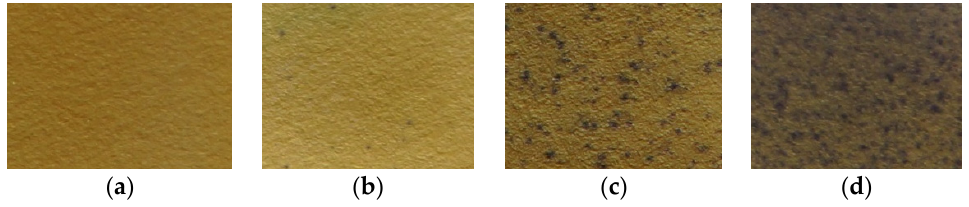
Figure 4. Reactive Papers visual inspection test examples. Change of colour to blue from yellow occurs on exposure. Amount of colour change used for visual inspection. ( a ) No Exposure; ( b ) Minor Exposure; ( c ) Moderate Exposure; and ( d ) Major Exposure.